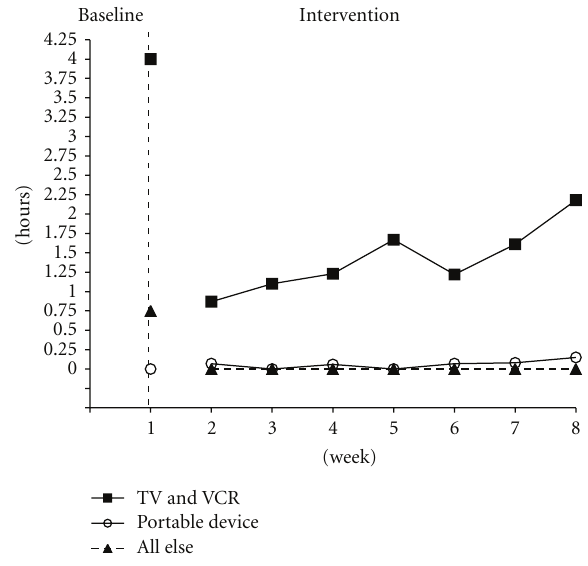
Figure 2: Child 2 averaged weekly media use by form over